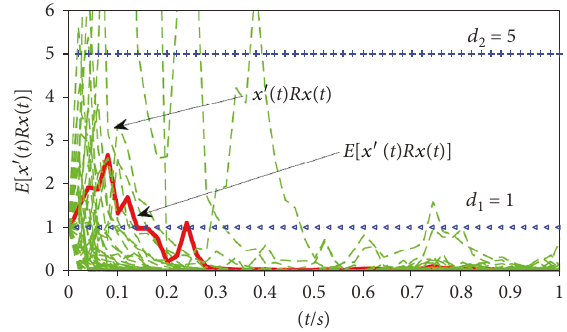
Figure 4: The response for E x ′ t Rx t